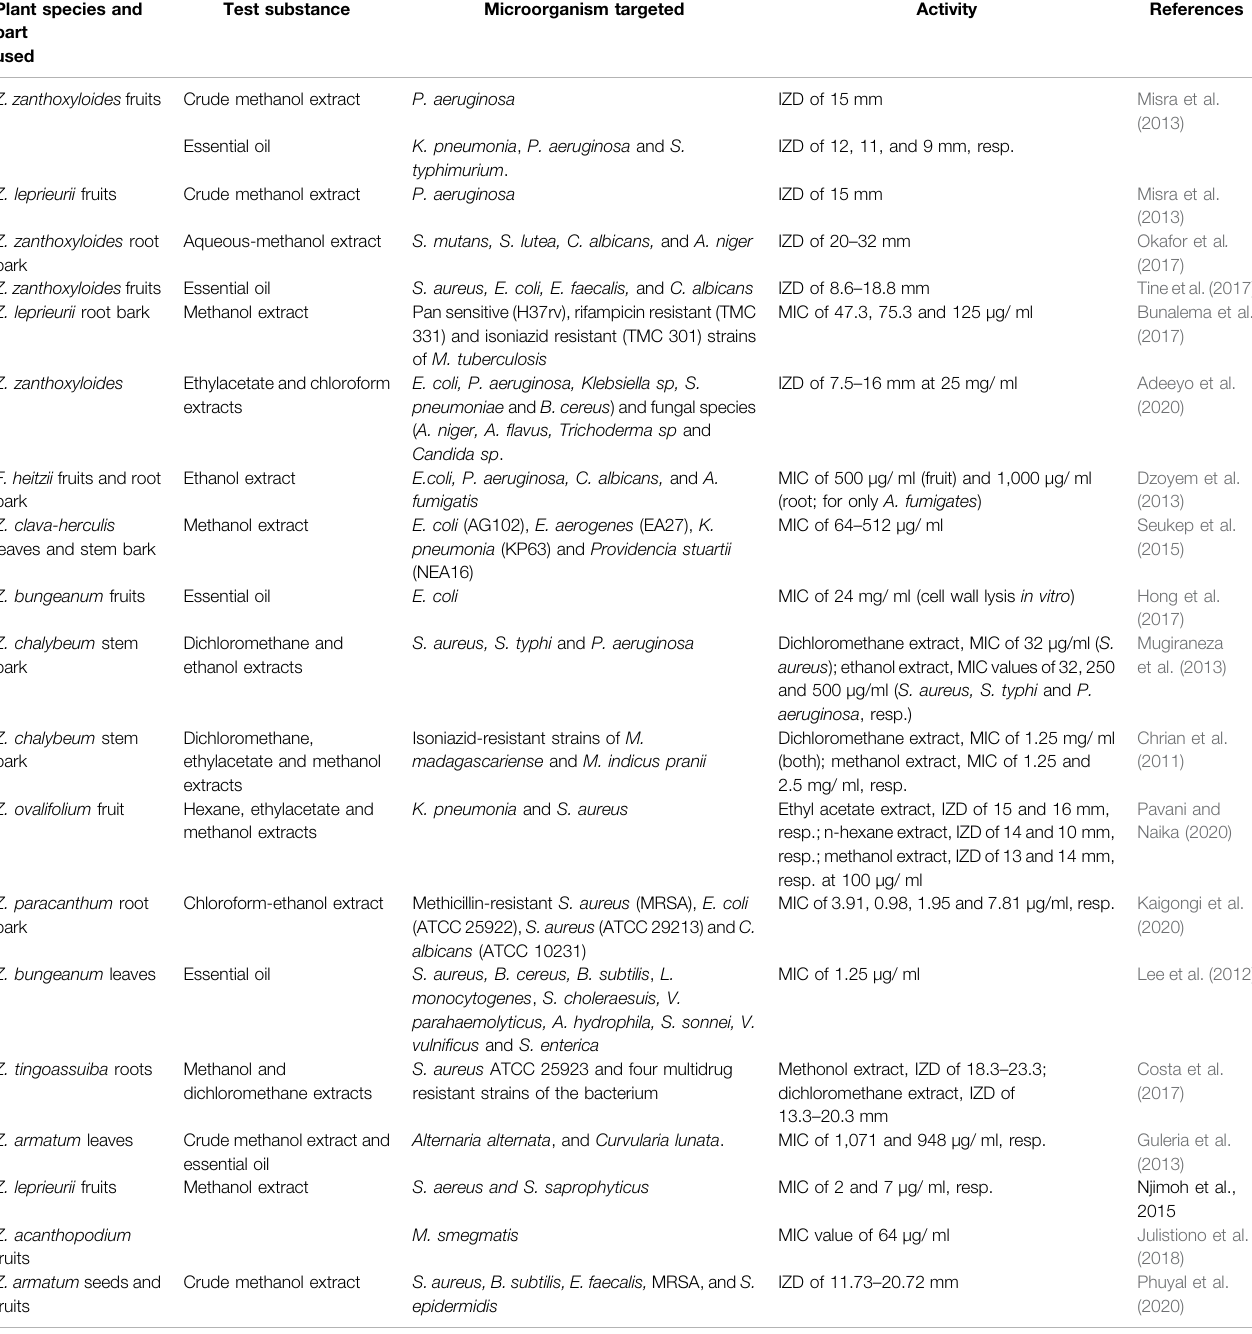
TABLE 3 | Summary of the antimicrobial activities of solvent extracts and essential oils from different part of Zanthoxylum species. Plant species and